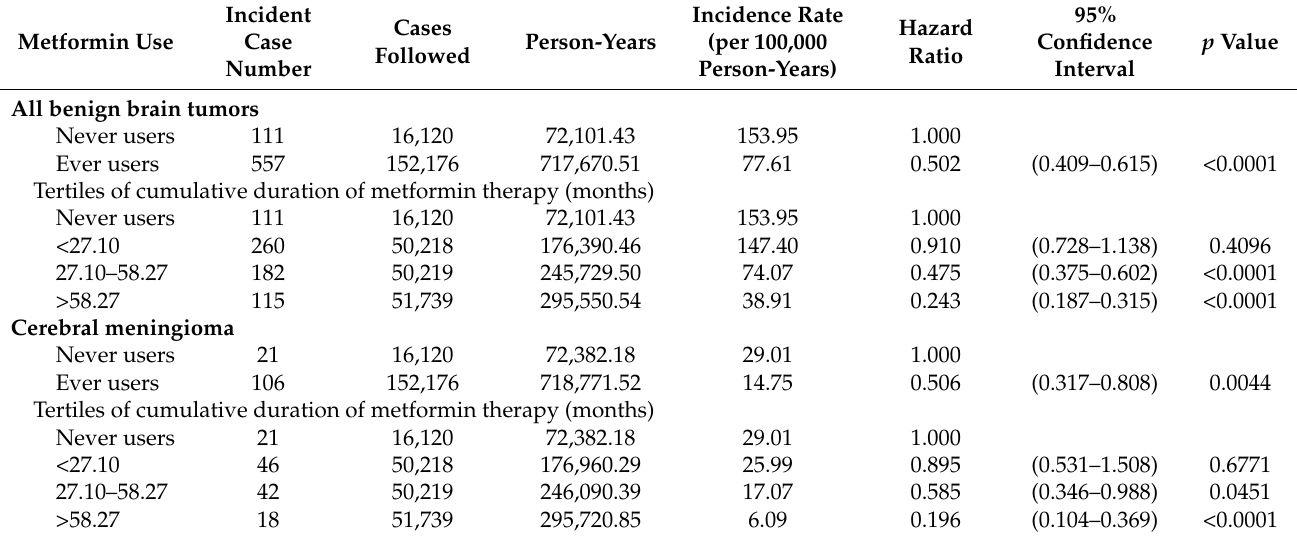
Table 2. Incidence rates of benign brain tumors by metformin exposure and hazard ratios comparing exposed to unexposed